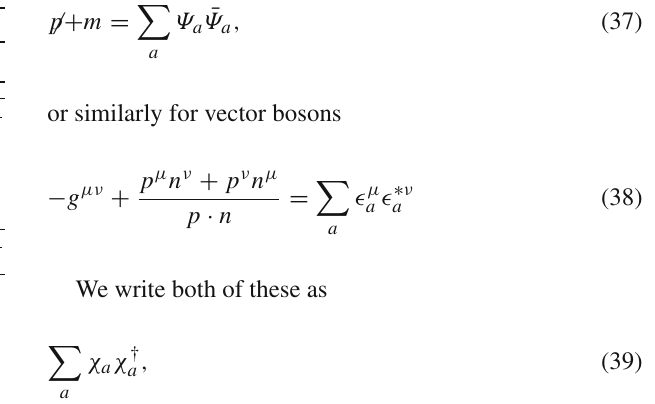
= ± 1 for quarks and ˜ q is the 0 , 1 2